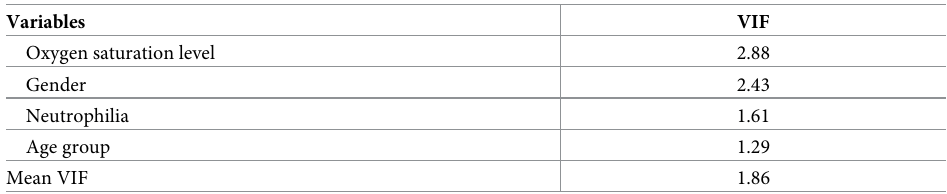
Table 1. Multicollinearity assessment